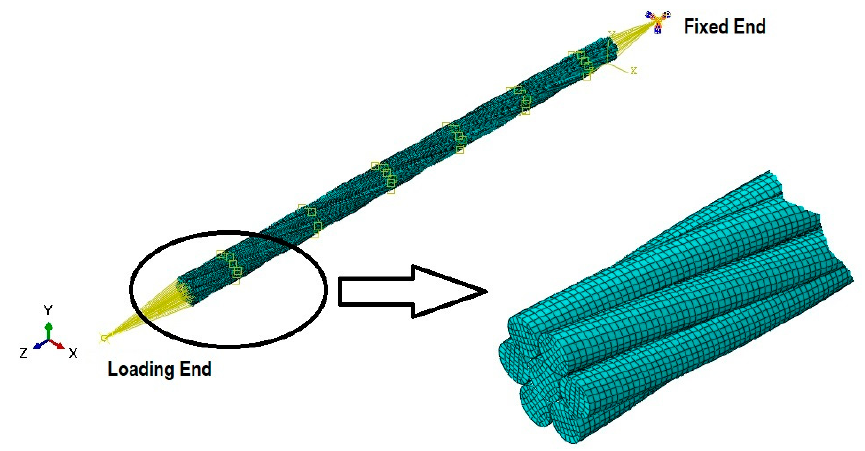
Figure 1. Wire Rope Strand Interaction, Boundary Conditions and detail of Mesh.